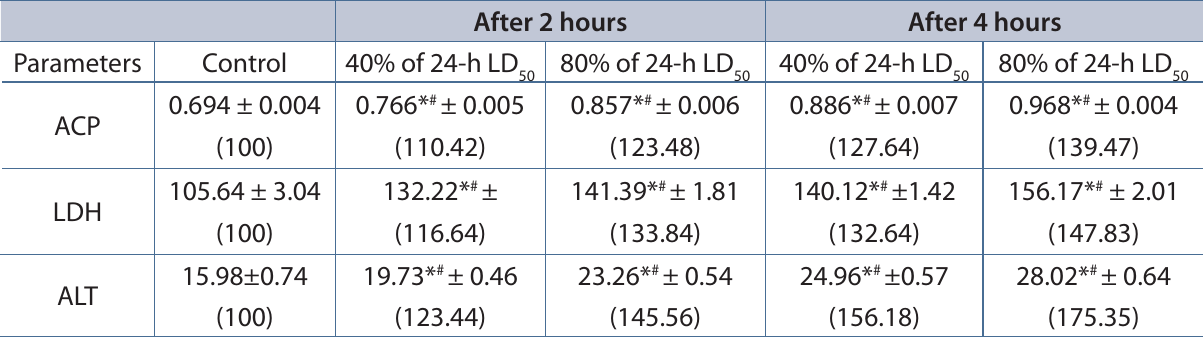
Table 3. Effect of 40% and 80% of 24-h LD of M. tamulus gangeticus venom on acid phosphatase (ACP), 50 lactic dehydrogenase (LDH) and alanine aminotransferase (ALT) levels in the blood serum of albino